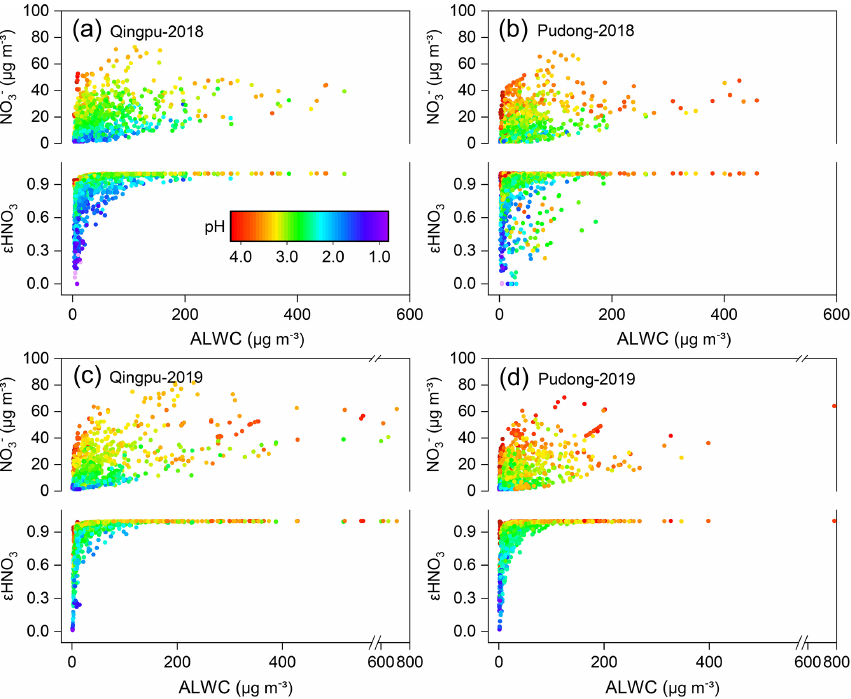
Figure 5. Particulate nitrate concentration and its fraction to total nitrate ( ε HNO 3 ) as a function of ALWC and aerosol pH at (a, c) Qingpu and (b, d) Pudong sites in the winter of 2018 and 2019. The circles are colored according to aerosol